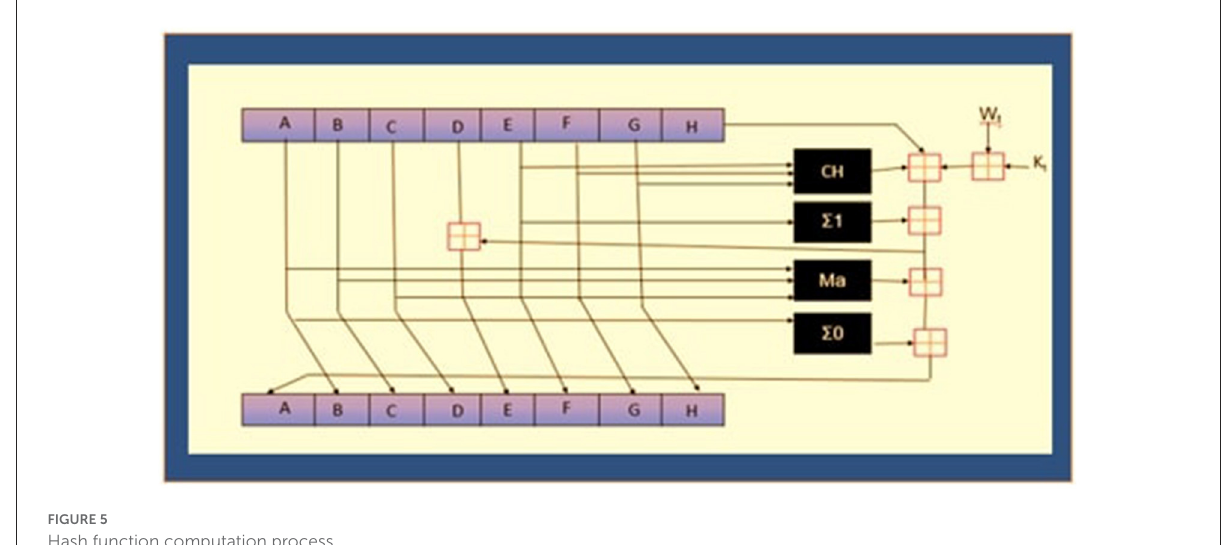
FIGURE5 Hash function computation process.